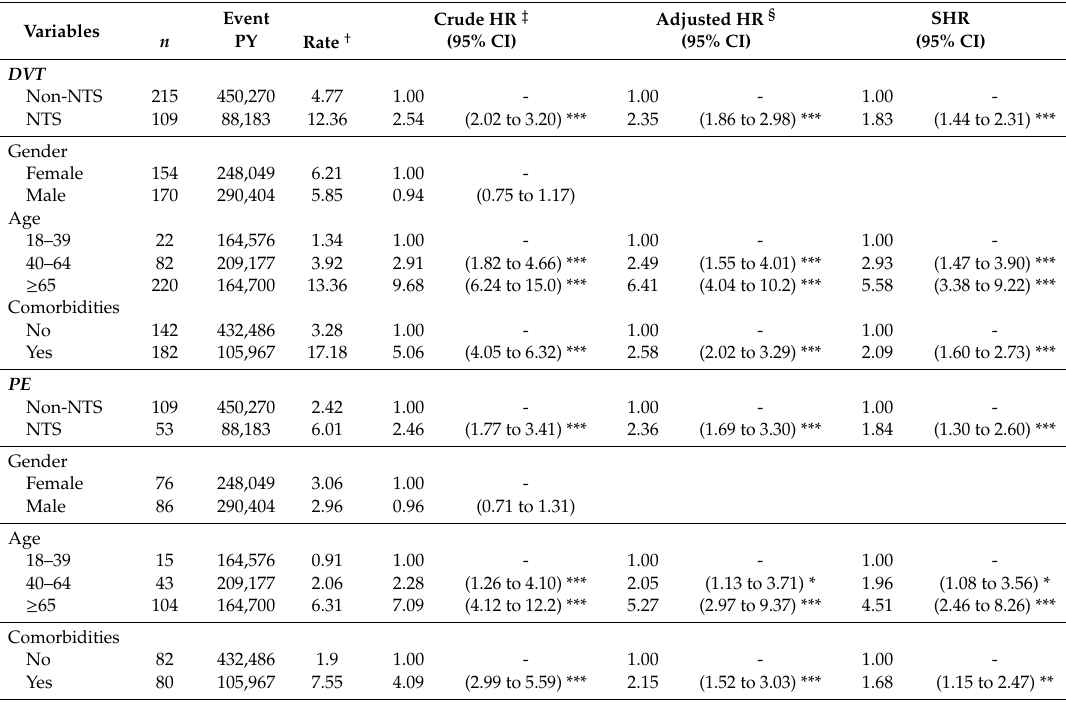
Table 2. Incidence and hazard ratios for deep vein thrombosis (DVT) and pulmonary embolism (PE), comparing patients with and without